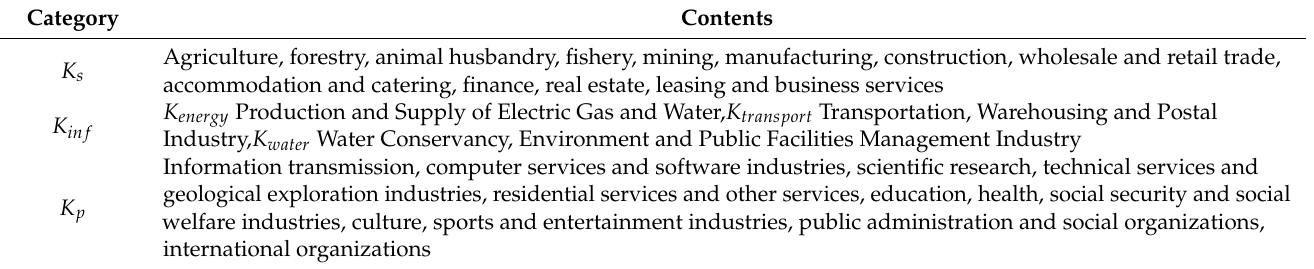
Table 1. Classification of capital stock